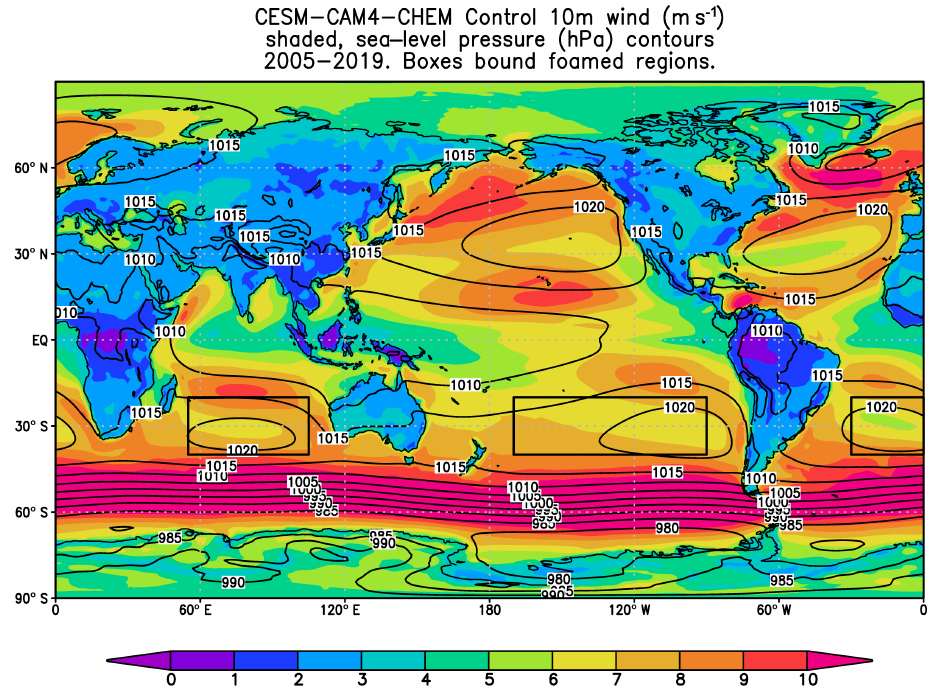
Figure 1. Applied forcing and global mean temperature response. Ocean albedo changed from a daily average of 0.06, which includes a very small daily cycle, to a fixed value of 0.15 with no daily cycle, over “foam regions”, 20 ◦ N–20 ◦ S, 90–170 ◦ W (South Pacific Ocean), 20 ◦ N–20 ◦ S, 30 ◦ W–0 ◦ E (South Atlantic Ocean) and 20 ◦ N–20 ◦ S, 55–105 ◦ E (South Indian Ocean). Each foamed region is outlined in black. Control-run sea-level pressure (mb) is shown with contours and 10m winds (ms − 1 ) are shaded.